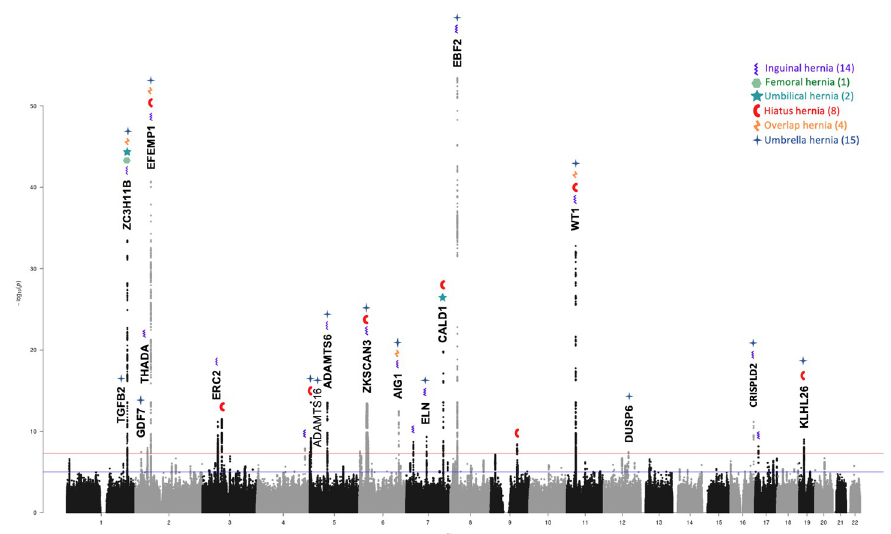
Fig 6. 24 loci discovered to confer shared hernia susceptibility after multivariate meta-analysis in 57,418 cases and 287,090 controls in metaUSAT. Each metaUSAT locus is annotated according to whether it was genome-wide significant in the individual, overlap or umbrella